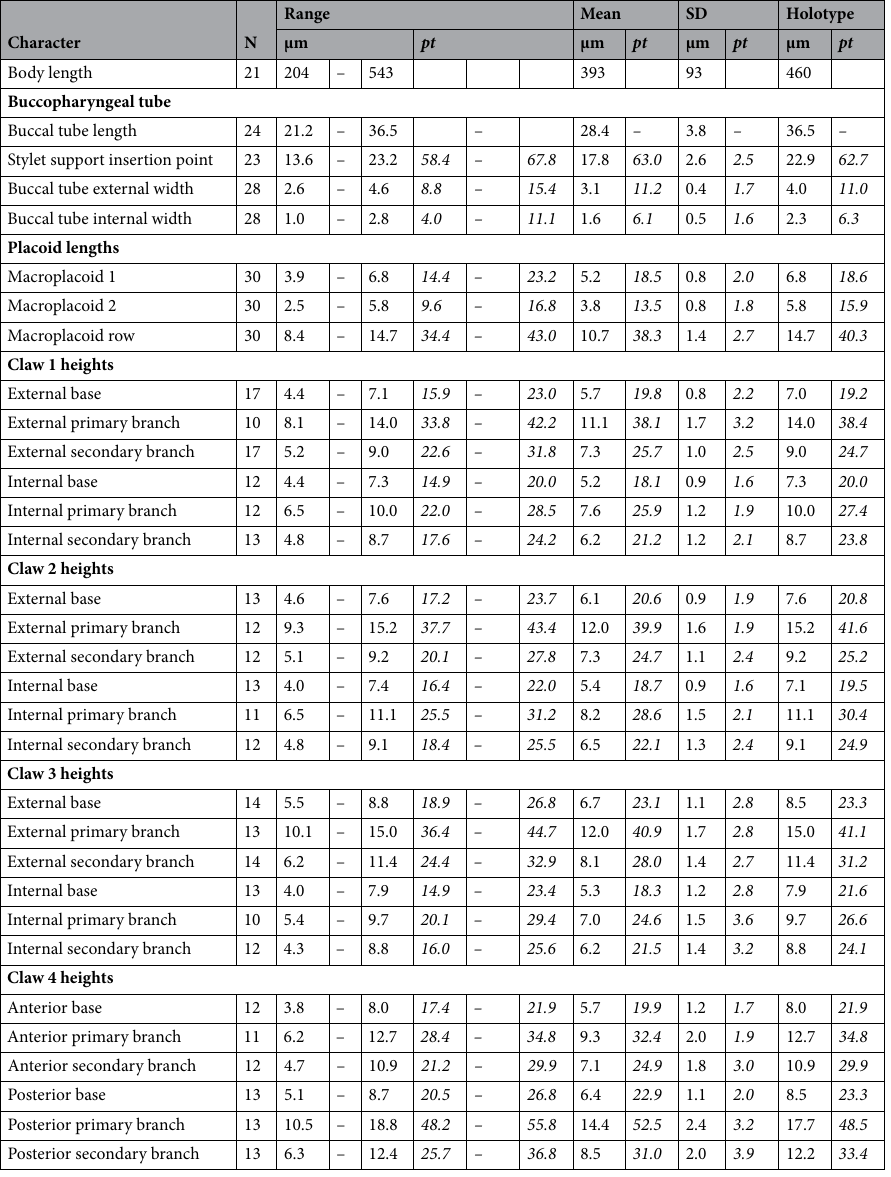
Table 1. Measurements (in µm) of selected morphological structures of Hypsibius nivalis sp. nov., individuals mounted in Hoyer’s medium (N—number of the measured structures; range—the smallest and the largest measurements of the structure, SD—standard deviation). The pt values are in